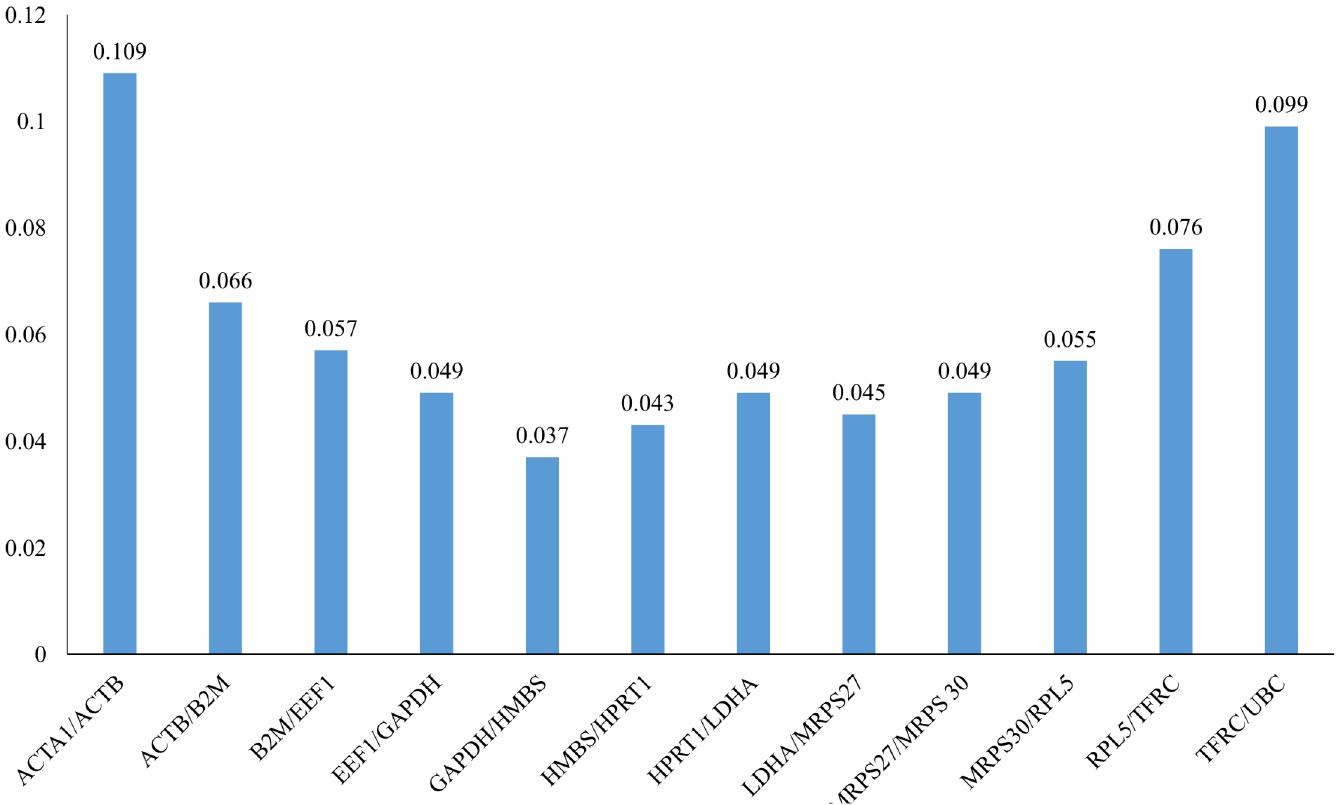
Fig 3. Determination of the Optimal Number of Control Genes for Normalization. This graph show the geNorm Excel pairwise variation (V) analysis. These values were used to determine optimal number of reference genes based on V-value for normalization in RT-qPCR reaction. Each bar represents change in normalization accuracy when stepwise adding more reference